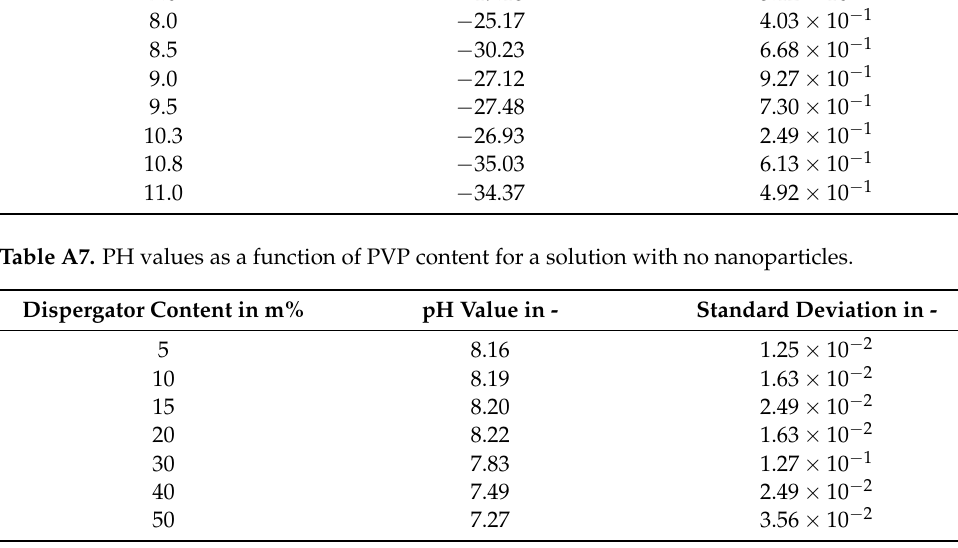
Table A8. PH values as a function of graphite content for a solution with 20 m% PVP. Graphite Content in m%